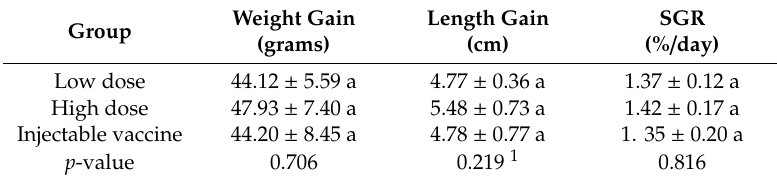
Table 4. Weight gain, length gain and specific growth rate (SGR) of Atlantic salmon ( Salmo salar ) fed with experimental diets (low dose oral vaccine, high dose oral vaccine, injectable vaccine).